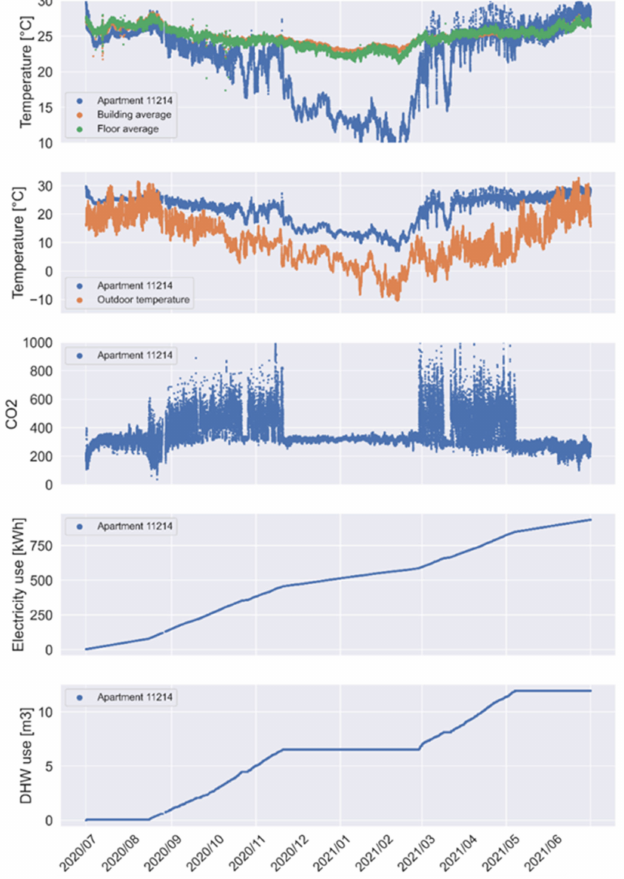
Figure 37. Indoor temperature, CO 2 concentration, cumulative electricity use and cumulative DHW use of apartment